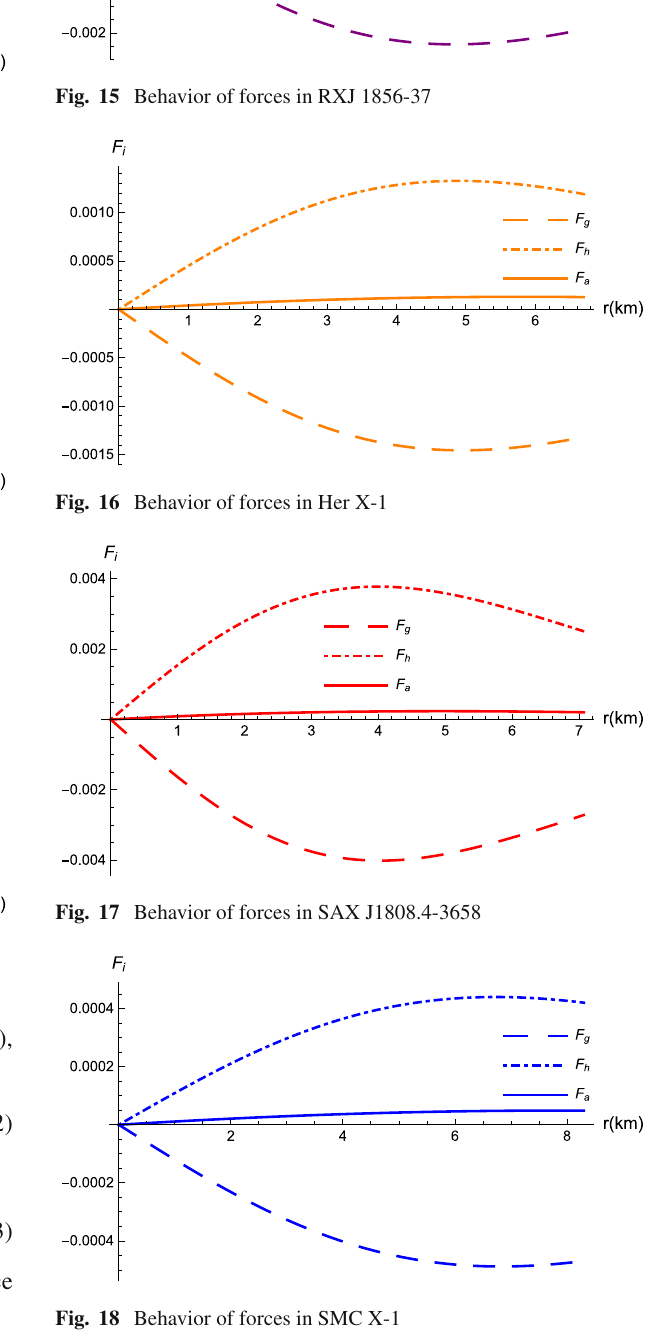
Fig. 12 Adiabatic Index for Cen X-3